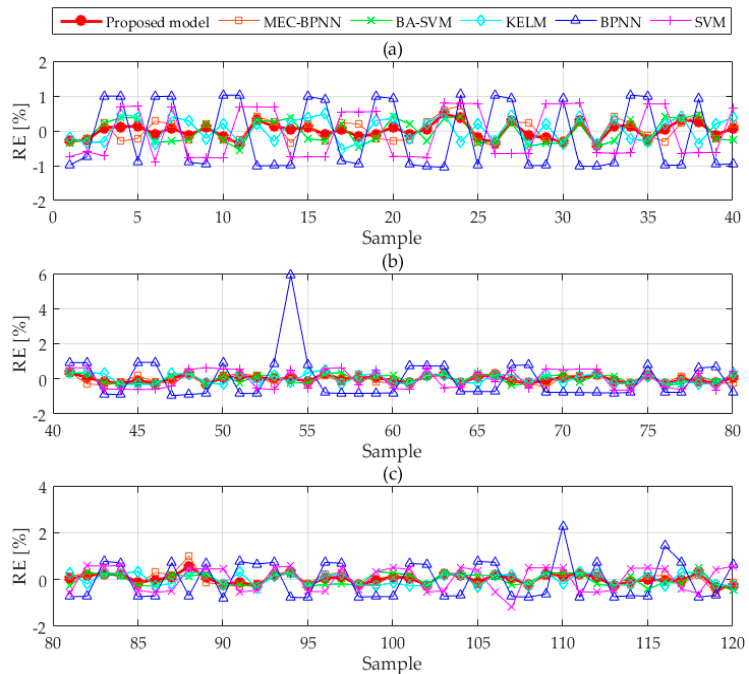
Figure 5. The relative errors curve of each method: ( a ) the relative error from 1 to 40 sample point; ( b ) the relative error from 41 to 80 sample point; ( c ) the relative error from 81 to 120 sample point.